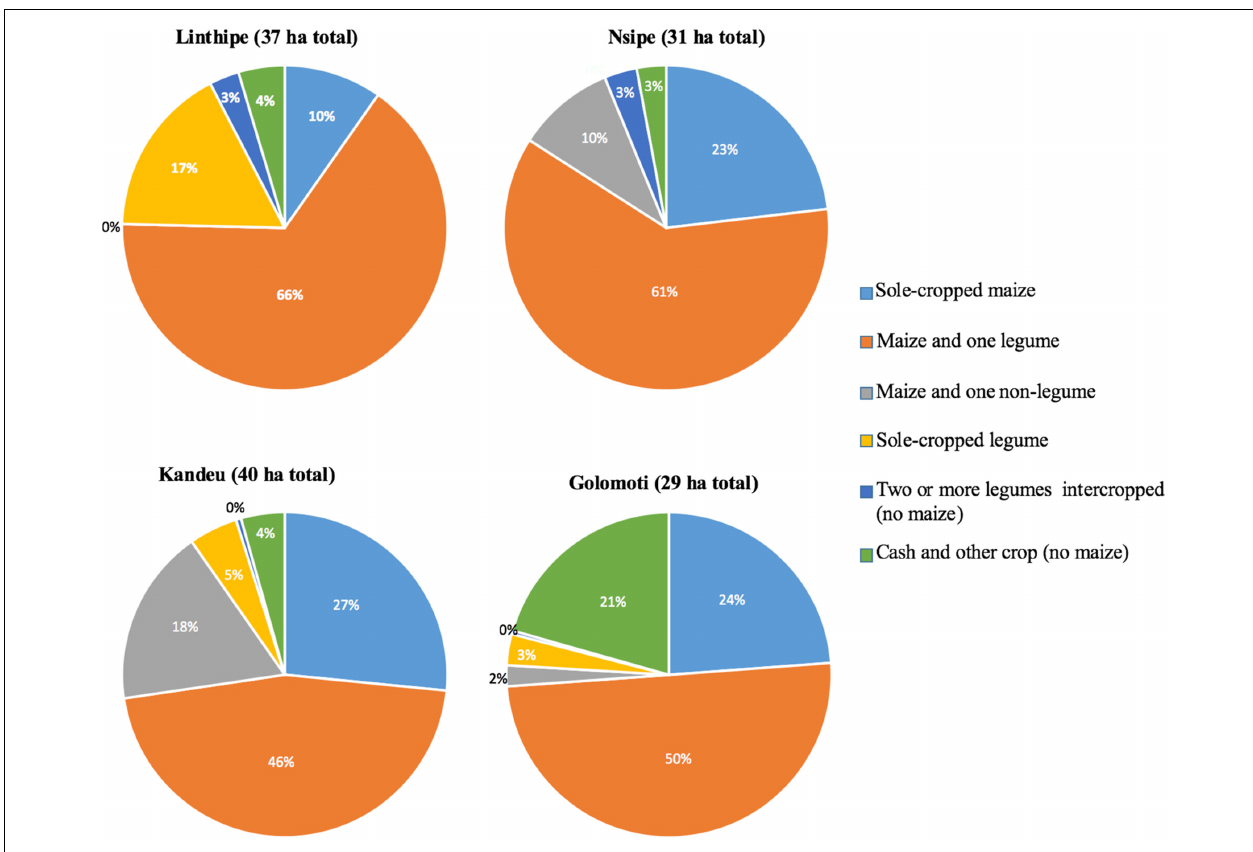
FIGURE 3 | Proportion of area devoted to each crop is shown in this figure for low (Golomoti), medium (Nsipe and Kandeu) and high (Linthipe) potential sites in Central Malawi based on project survey conducted July of 2013, fields n =